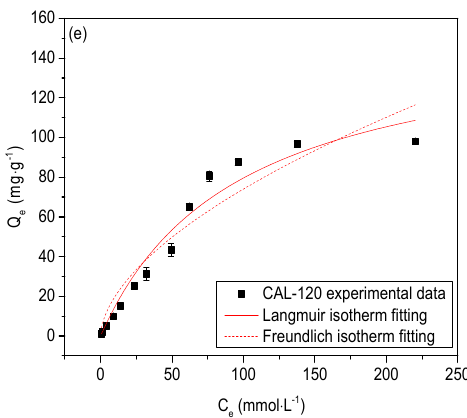
Figure 5. The effect of initial Cl − concentration on Cl − adsorption on CAL and nonlinear fits achieved using Freundlich isotherm and Langmuir isotherm (( a ) CAL-60; ( b ) CAL-70; ( c ) CAL-80; ( d ) CAL-100; ( e ) CAL-120).